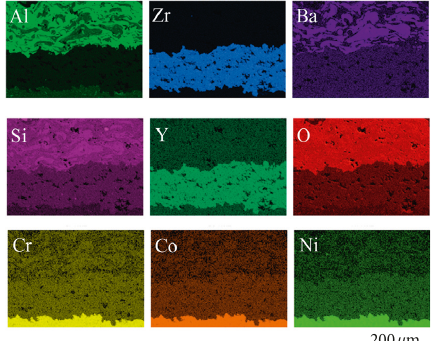
Figure 2: EDX elemental maps of TEBC showing distribution of the main elements presented in the TC and BC: (a) Al; (b) Zr; (c) Ba; (d) Si; (e) Y; (f) O; (g) Cr; (h) Co; (i)